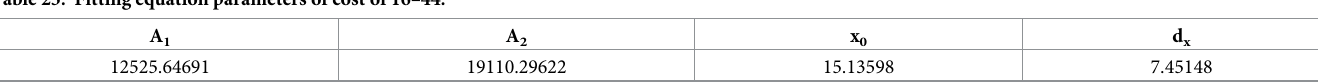
Fig 8. Delivery of efficiency of 16–44. https://doi.org/10.1371/journal.pone.0267043.g008 Table 23. Fitting equation parameters of cost of 16–44.